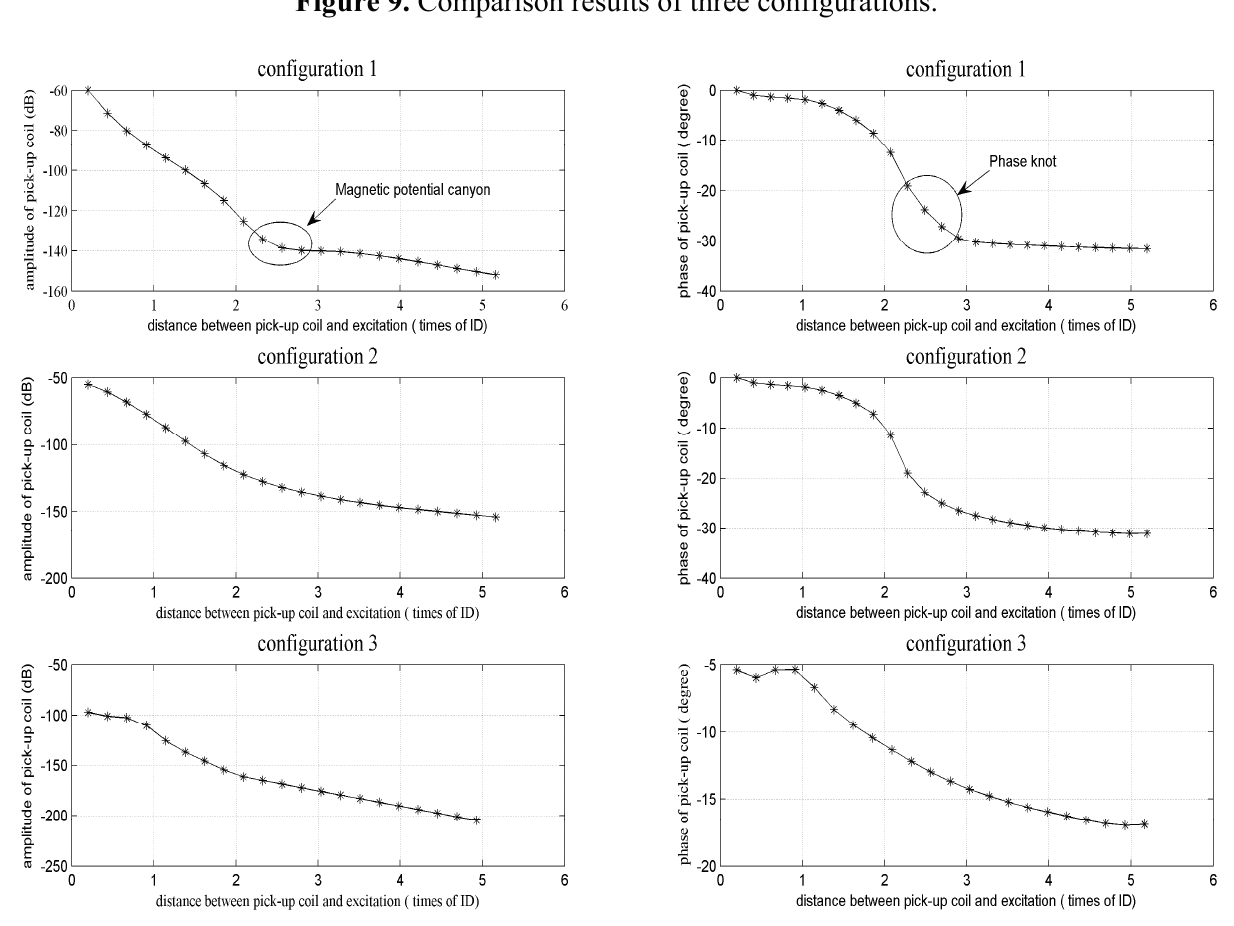
Figure 9. Comparison results of three